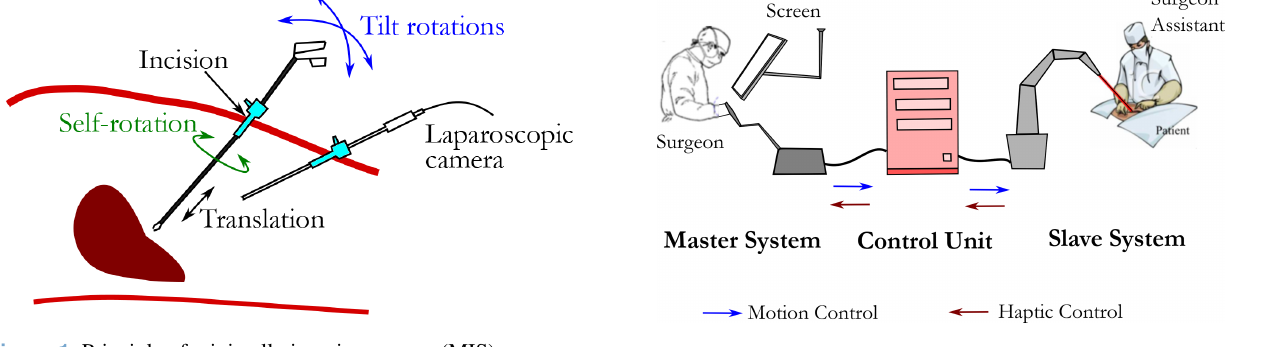
Figure 1. Principle of minimally invasive surgery (MIS). Figure 2. Principle of robotized MIS with haptic feedback.